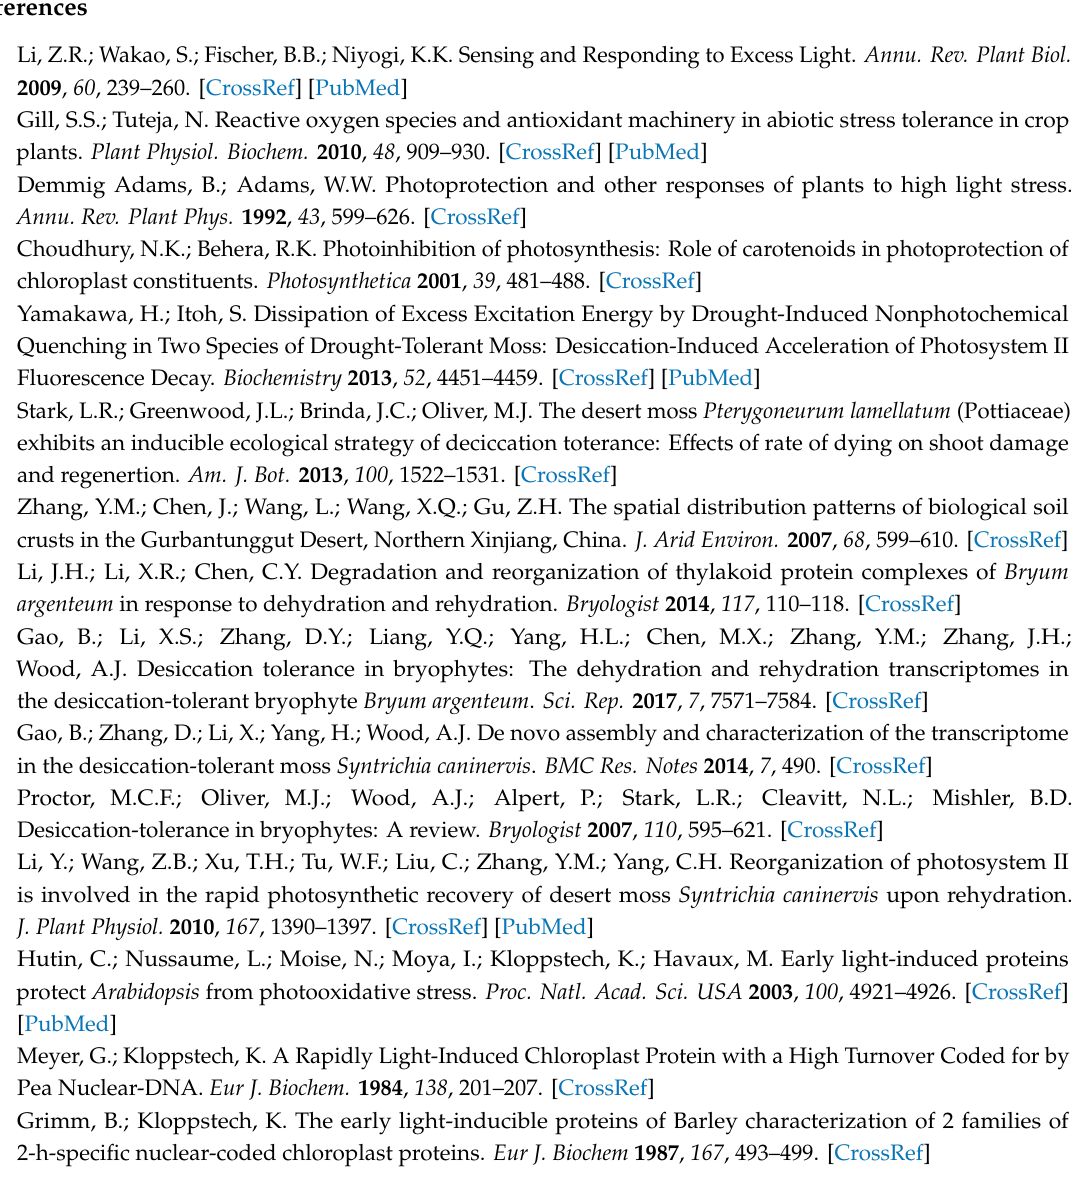
Figure S10. The change of chlorophyll content of WT, Atelip and transgenic lines at 0 h, 3 days and 3 weeks high light stress (1000 µ mol / m2 /